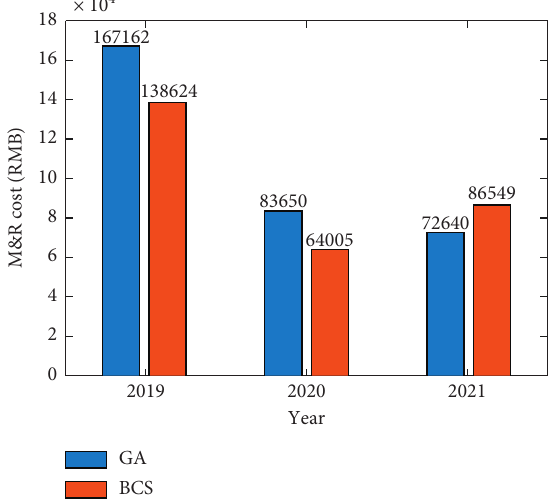
Figure 9: Budget allocation in each year under M&R cost minimization.